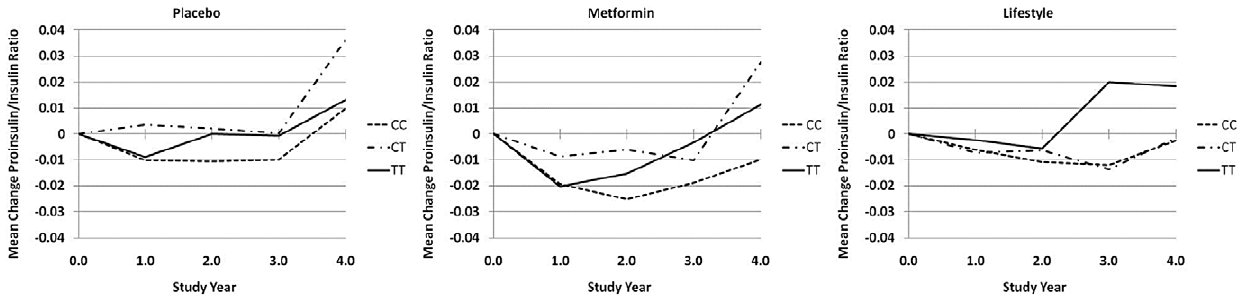
Figure 2. Mean change in proinsulin:insulin ratio in the Diabetes Prevention Program by treatment group and genotype at